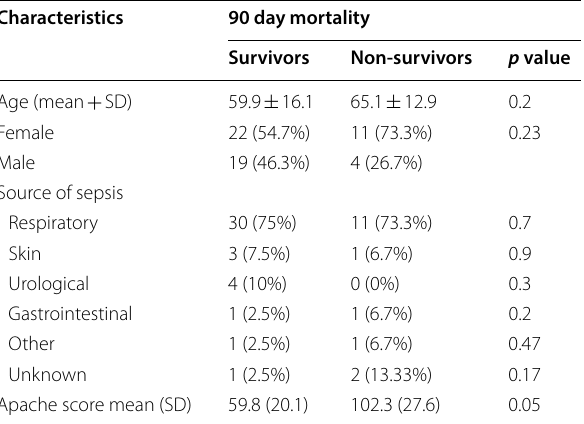
Table 2 Characteristics of study population